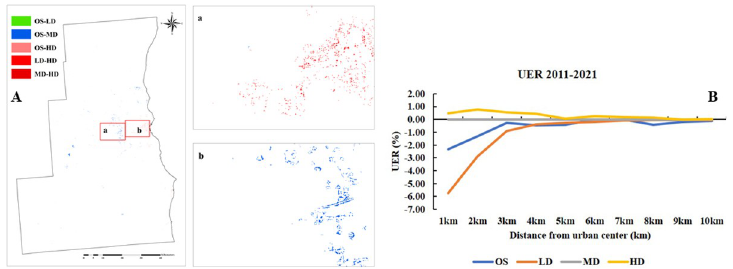
Fig 10. Urban density and Urban Expansion Rate (UER) difference between observed 2011 and simulated 2021. (A) Urban density difference between observed 2011 and simulated 2021. (B) Urban Expansion Rate (UER) difference between observed 2011 and simulated 2021.Labels of XX-YY indicated that observed 2011 was XX and simulated 2021 was YY.